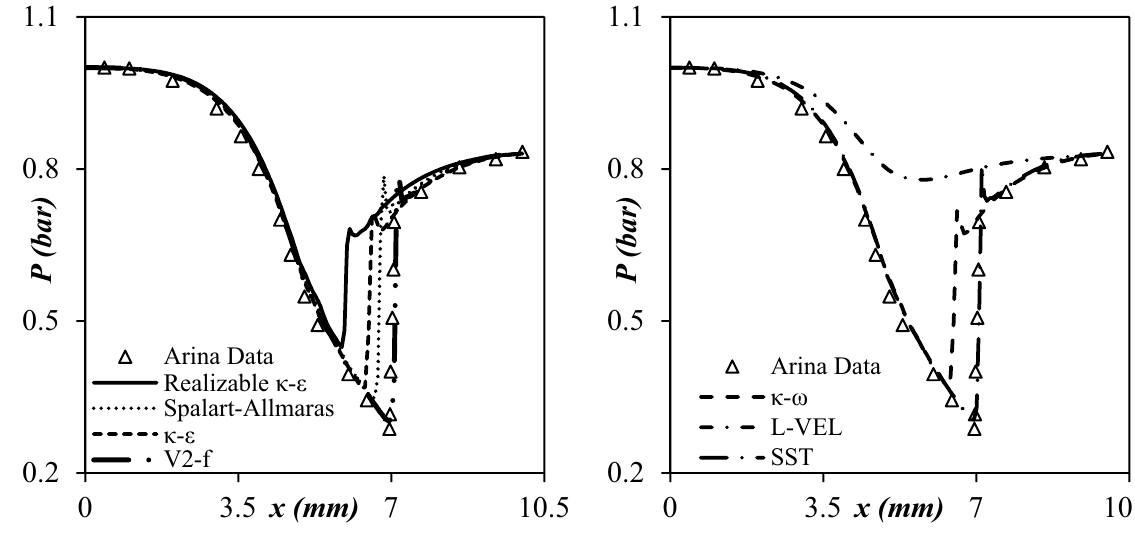
Figure 4. Predicted pressure profiles by different turbulence models. Turbulence